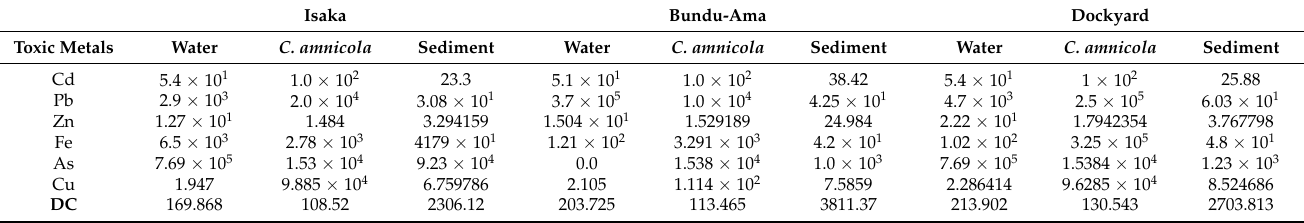
Table 3. Contamination factor (C f ) and degree of contamination (DC) of Cd, Pb, Zn, Fe, As, and Cu in the Isaka–Bundu tidal mangrove